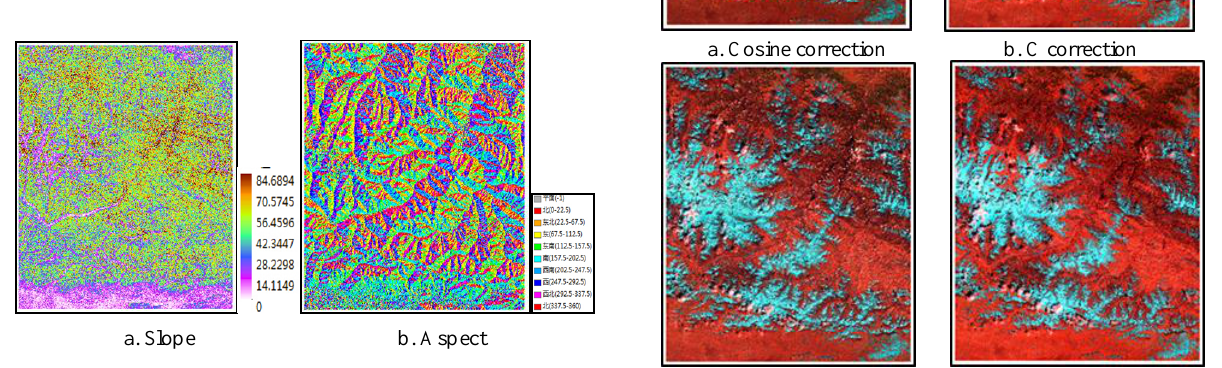
Figure 2. Experiment data procedure flow diagram